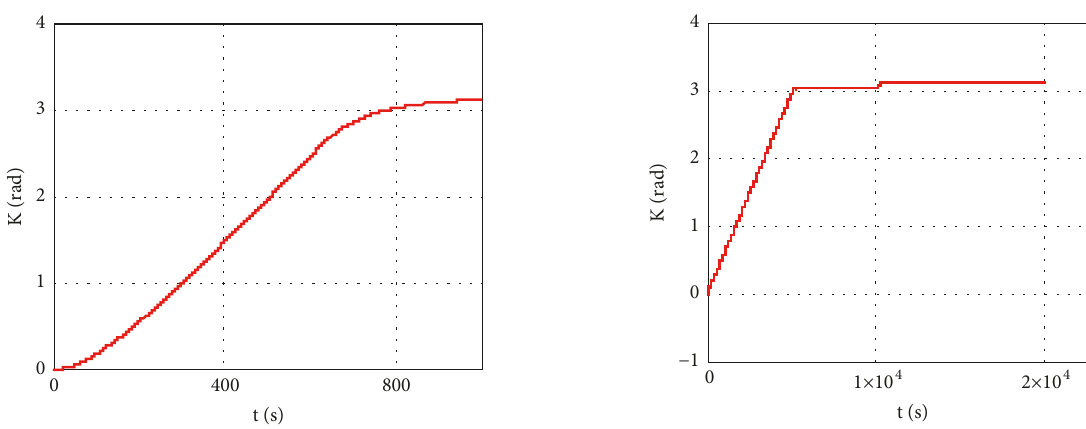
Figure 15: Time dependence of the heading angle during rotation towards the return course for values 𝑧 ∗ 3 = 0.005𝑟𝑎𝑑 ⋅ 𝑠 −1 , 𝑧 ∗ 6 = 3.4𝑟𝑎𝑑 ; 𝑇 = 0.1𝑠 , 𝐹 = 10 , 𝐹 = 0.01 , 𝑧 ∗ = 0.01 ⋅ sign (𝑧 ∗ ) 𝑢 6 7 7 6